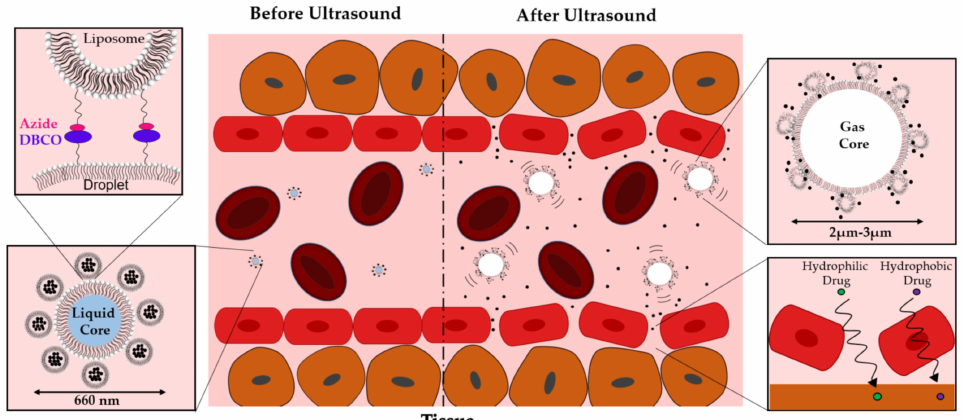
Figure 1. Schematic figure of phase changeable droplet-liposome clusters (PDLCs) activation in a vessel. Ultrasound induced droplet vaporization can both permeabilize vascular endothelium and disrupt liposomes within the construct to trigger intravascular drug